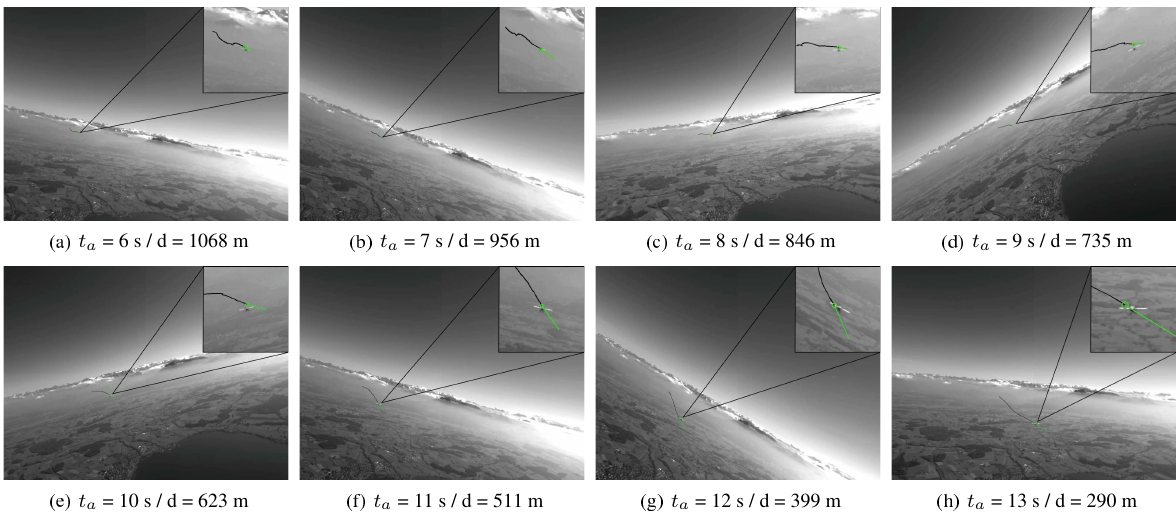
Figure 11: Example frames from the wingrock Scenario O at different time steps. The track is shown with its one second prediction in green and the track history in black. The time t a indicates the total ’alive time’ of the track. From frame (a) to (f) it can easily be seen that the period of the wingrock maneuver was approximately five seconds. This figure is best viewed in color. and correctly maintained for the rest of the scenario. Detecting